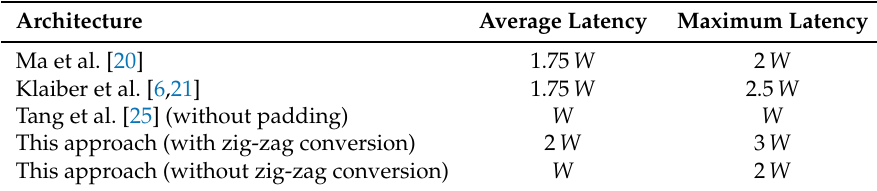
Table 6. Latency (in clock cycles) for an image of width W